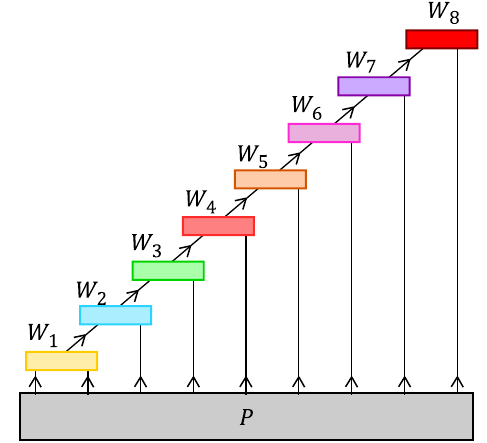
FIG. 10. A matrix product connector tensor network